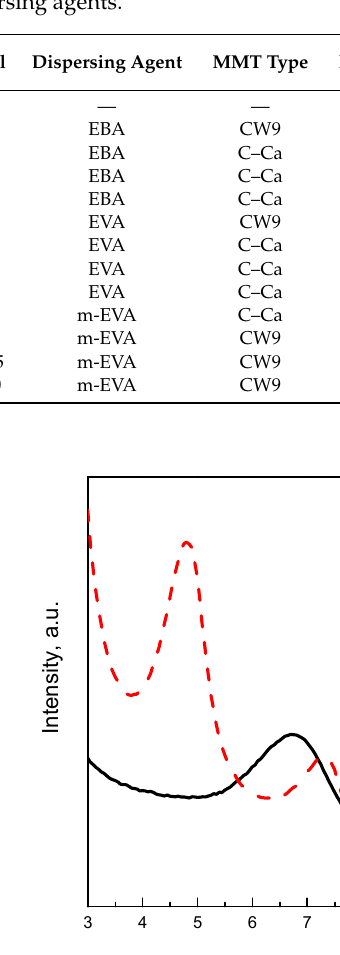
Table 1. Mechanical features of polyethylene (PE)composites with different montmorillonites (MMTs) and dispersing agents.